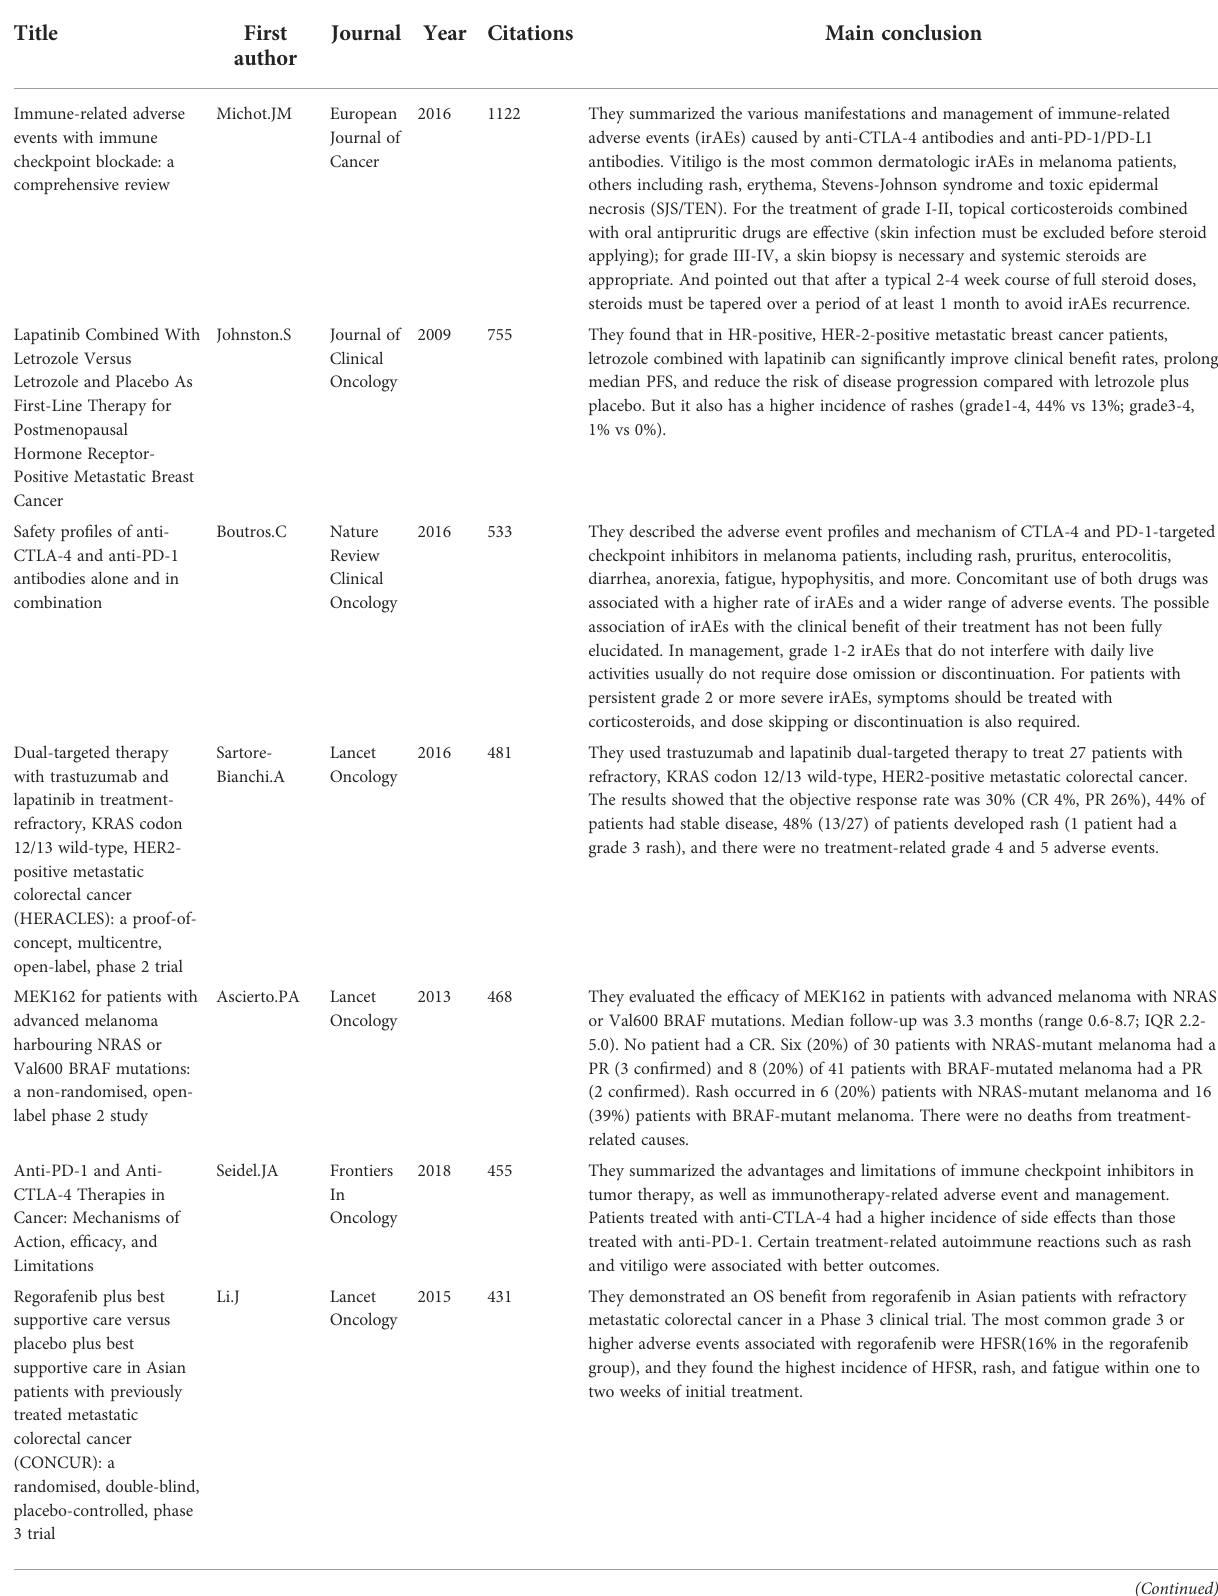
TABLE 5 The top 10 related articles with the most